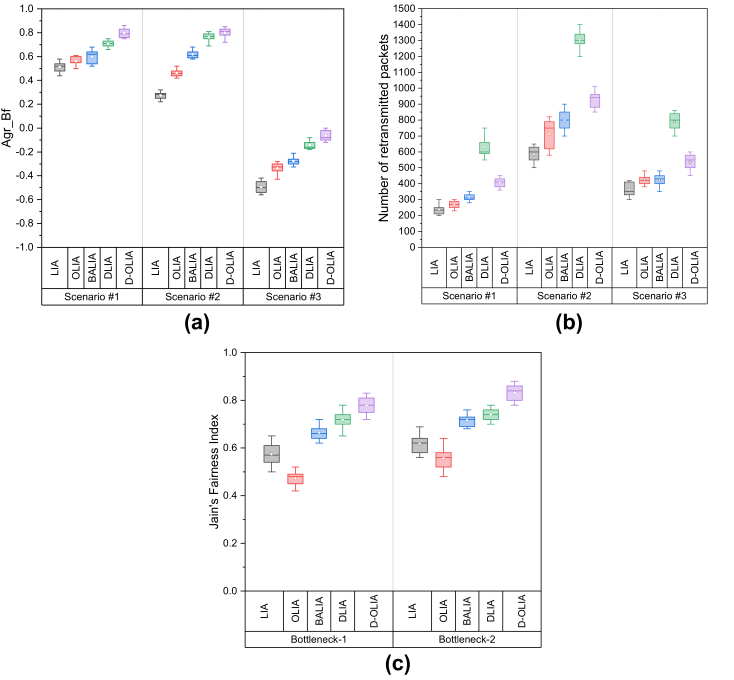
Figure 11. Performance of the considered MPTCP-CCAs in terms of ( a ) Agr_Bf, ( b ) the number of retransmitted packets, and ( c ) fairness among the MPTCP flows in Scenario